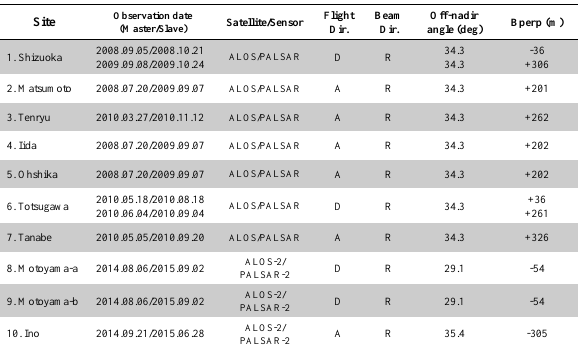
Table 1. Specification of InSAR imageries of 10 sites in this